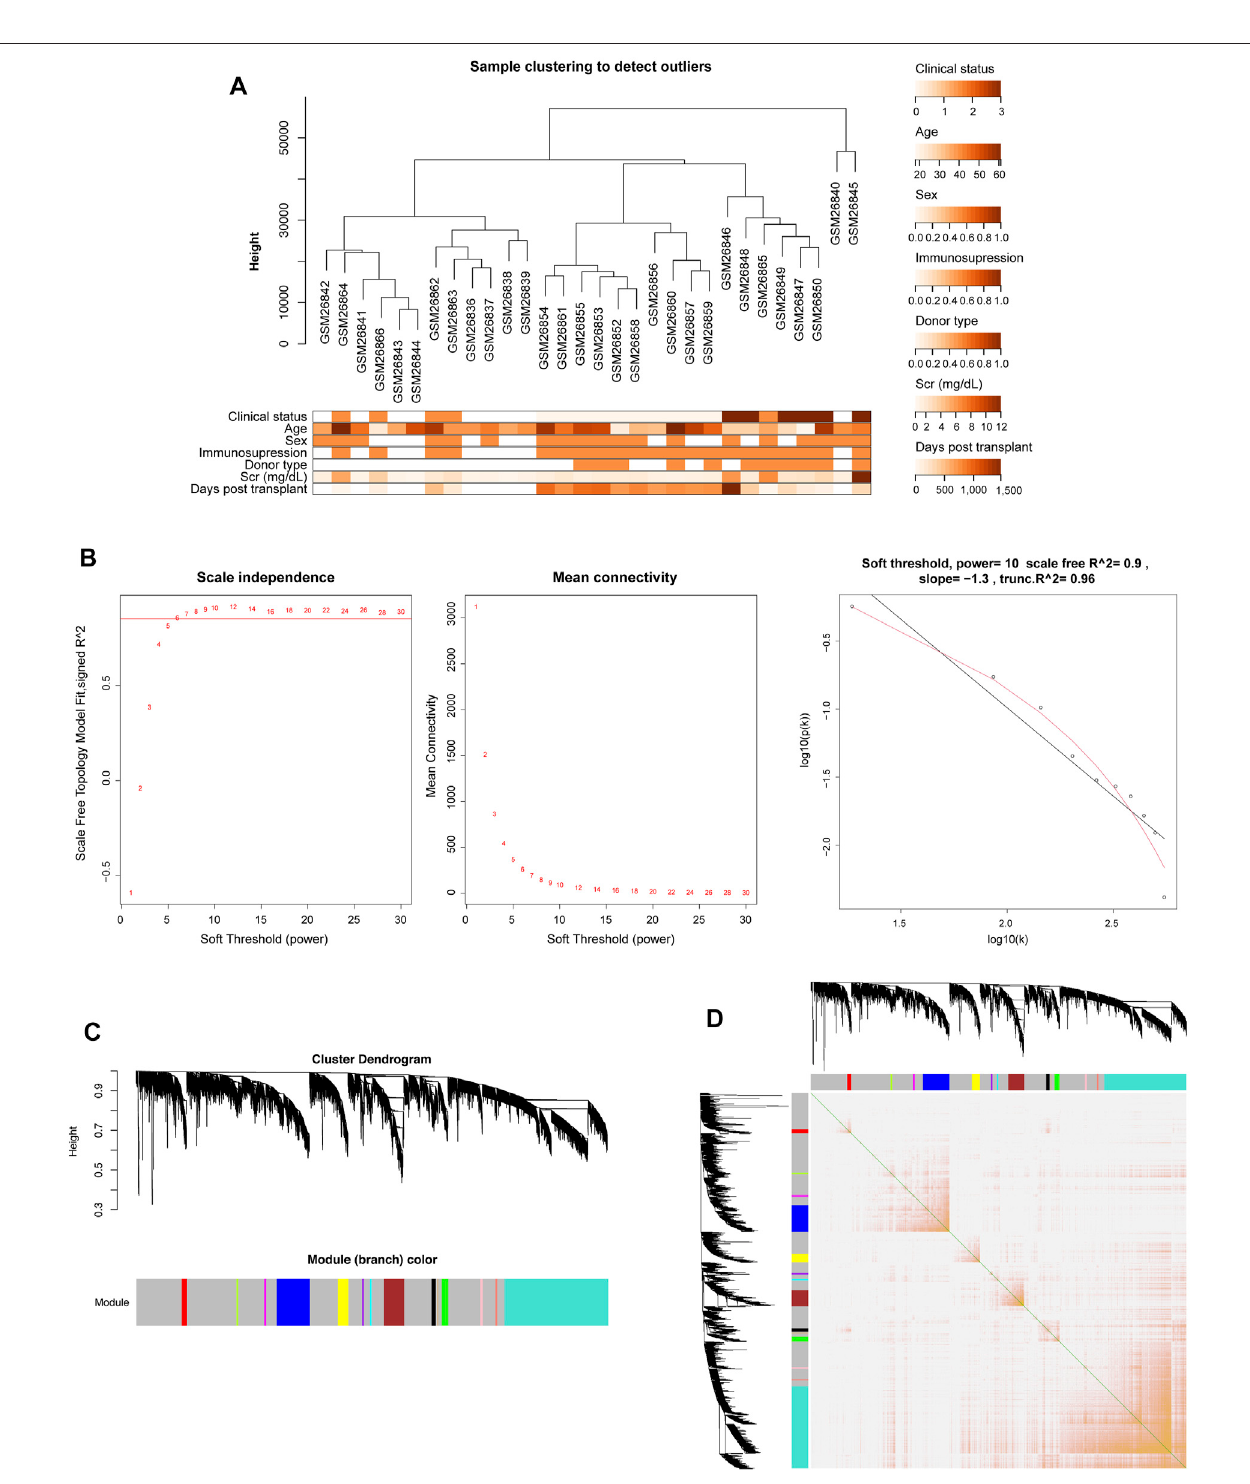
FIGURE2| Co-expressionnetworkconstructionofGSE1563analyzedbyWGCNA. (A) HierarchicalclusteringdendrogramofkidneysamplesinGSE1563andthe correspondingclinicaltrait heatmap. (B) Analysisofappropriatesoft-thresholding powers. Thered lineindicatesacorrelationcoef fi cient of0.85.The secondplotshows average network connectivity under weighting coef fi cients. The third plot indicates the correlation of log (k) and log [P (k)]. (C) Clustering dendrograms of 9,155 genes in 30 samples, from which 14 co-expression modules were constructed with different colors. (D) Heatmap plot depicts the TOM among all genes in the analysis, which shows the interactions among co-expression modules. The stronger intensity of orange indicates greater overlaps.